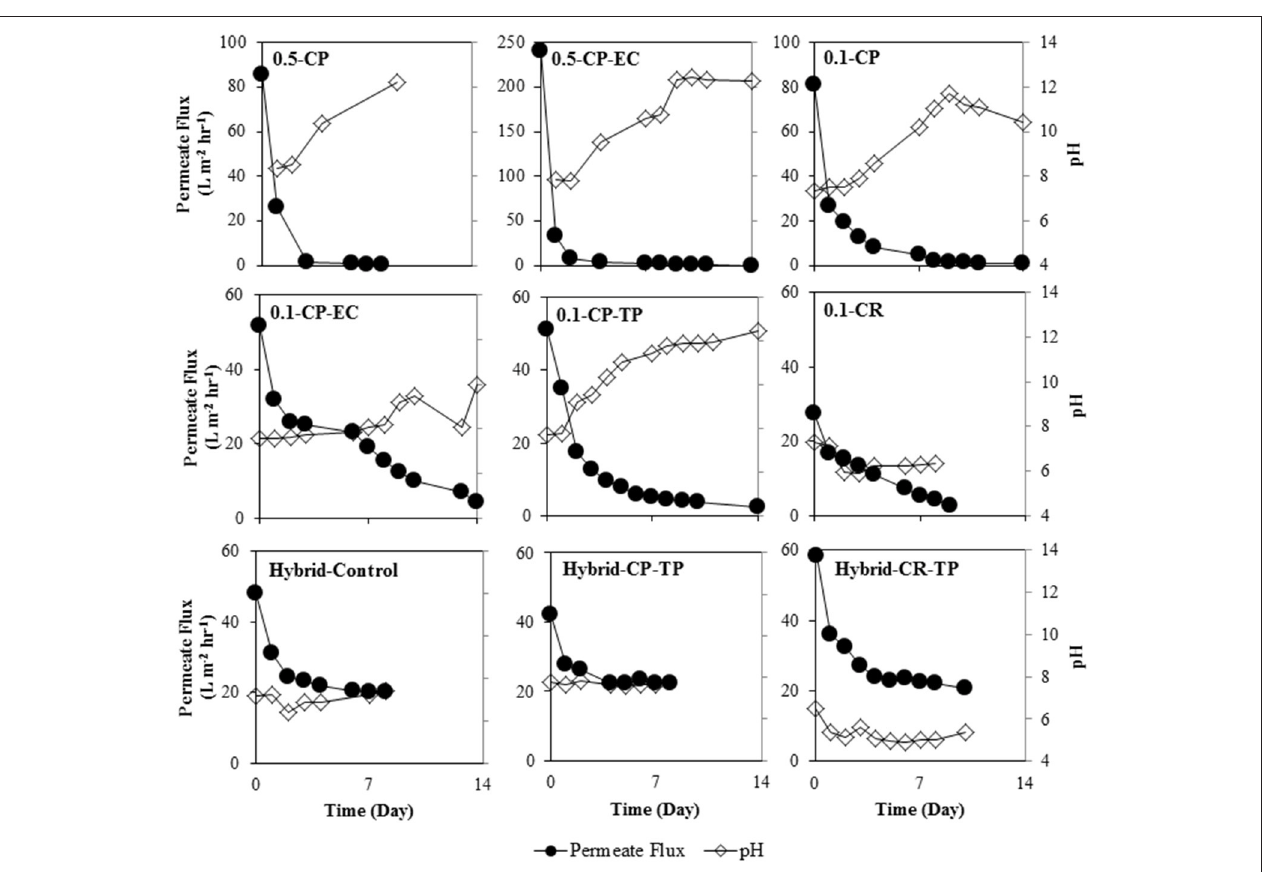
FIGURE 4 | Permeate fluxes and permeate pH (note the two y-axes for permeate fluxes and pH on the left and right in each plot, respectively) over time as a result of operating BES integrated with AnMBR with crossflow filtration using filtering anode of filter grade 0.1 and 0.5 µ m stainless steel membranes; with electrochemical cleaning (EC) and turbulence promotor (TP) application as fouling mitigations methods, and the cathode located on the permeate side (CP) and retentate side (CR); and using polymeric membrane alone (Hybrid-Control) and polymeric membrane combined with a stainless steel mesh for hybrid anode configuration; with turbulence promotor (TP) application as fouling mitigation method, and the cathode located on the permeate side (CP) and retentate side